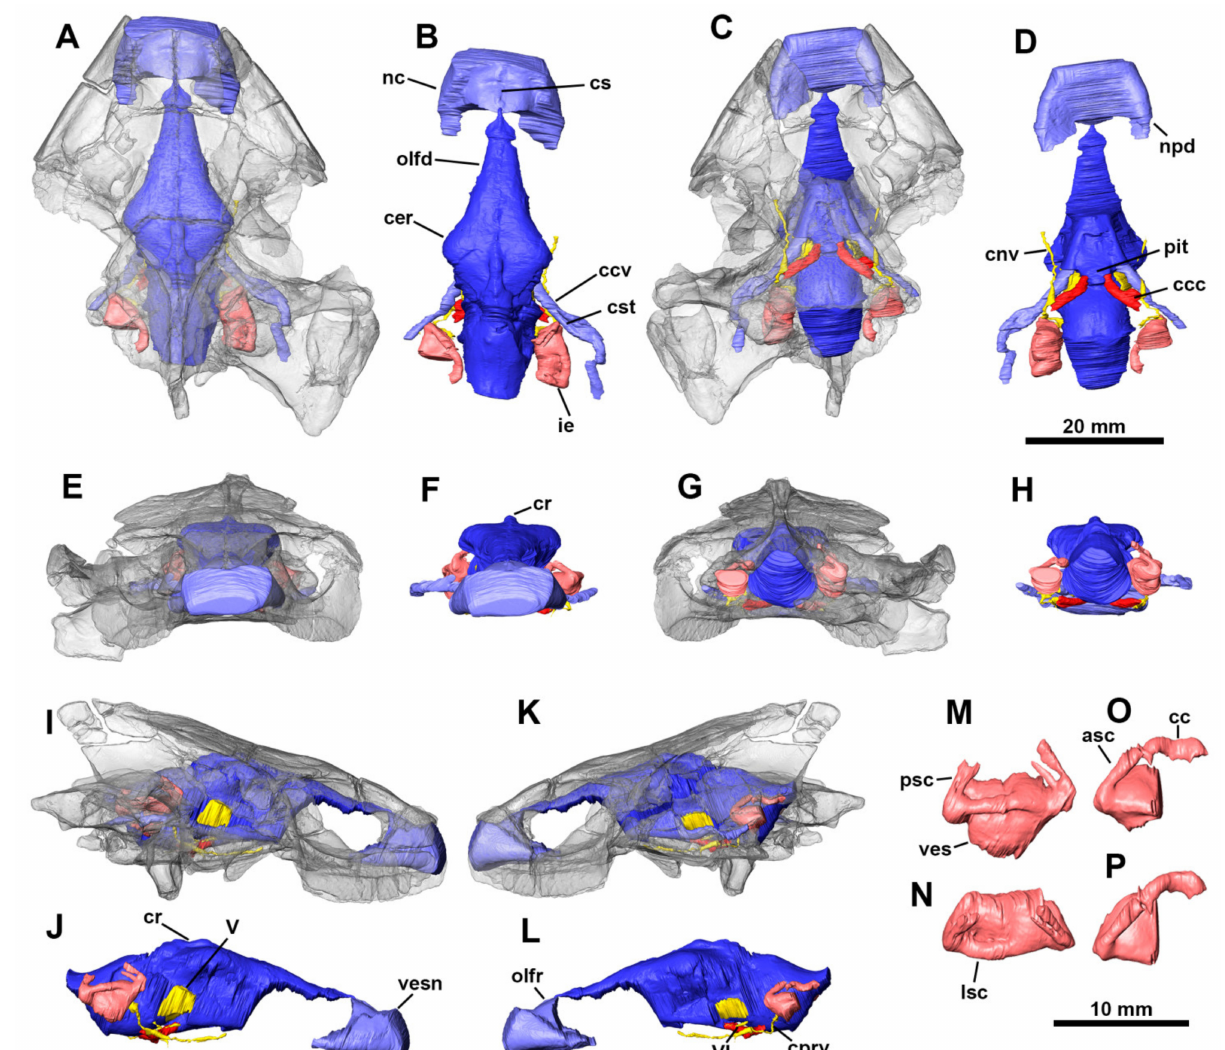
Figure 5. Osteological and neuroanatomical three-dimensional virtual reconstructions of the specimen MNHN.F.SPP34, the paratype of Tartaruscola teodorii (Bothremydidae, Foxemydina), from the lower Ypresian (early Eocene) of Saint-Papoul (Aude, France). The osseous elements (in grey) have been visualized as transparent ( A , C , E , G , I , K ) in order to show the reconstruction of the endocast of cranial and nasal cavities (in blue) ( B , D , F , H , J , L ). The reconstructions are presented in dorsal ( A , B ), ventral ( C , D ), anterior ( E , F ), posterior ( G , H ), right lateral ( I , J ), and left lateral ( K , L ) views. ( M , N ), Right inner ear reconstruction in lateral ( M ) and dorsal ( N ) views. ( O , P ), Left incomplete inner ear in lateral ( O ) and dorsal ( P ) views. Abbreviations: asc, anterior semicircular canal; cc, crus communis; ccc, canalis caroticus cerebralis; ccv, canalis cavernosus; cer, cerebral hemisphere; cnv, canalis nervi vidiani; cprv, canalis pro ramo vidiani; cr, cartilaginous ridge; cs, cartilaginous septum; cst, canalis stapedio-temporalis; ie, inner ear; lsc, lateral semicircular canal; nc, nasal cavities; npd, nasopharyngeal duct; olfd, olfactory duct; olfr, olfactory region; pit, pituitary fossa; psc, posterior semicircular canal; V, trigeminal nerve; ves, vestibulum; vesn, vestibulum nasi; VI, abducens